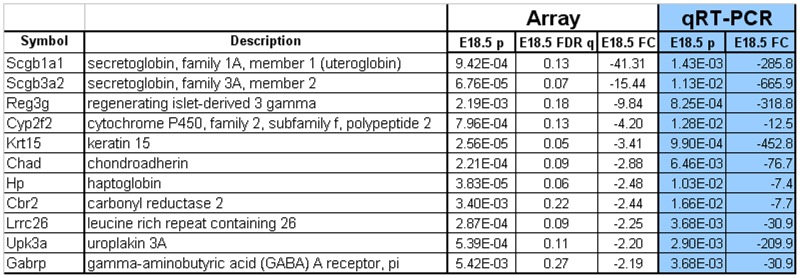
Microarray-based identification of mRNAs downregulated in RbpjkCNULL lungs at E18.5 and validation using qRT-PCR.Genes downregulated greater than two-fold (p-value <0.05 and FDR-q value <0.28) are shown here. FC = fold change; FDR-q = Benjamini-Hochberg False Discovery Rate. A total of n = 3 lungs per condition from control (CTRL) and Shh
cre/+; Rbp Flox/Flox (RbpjkCNULL) were used for the respective analyses.